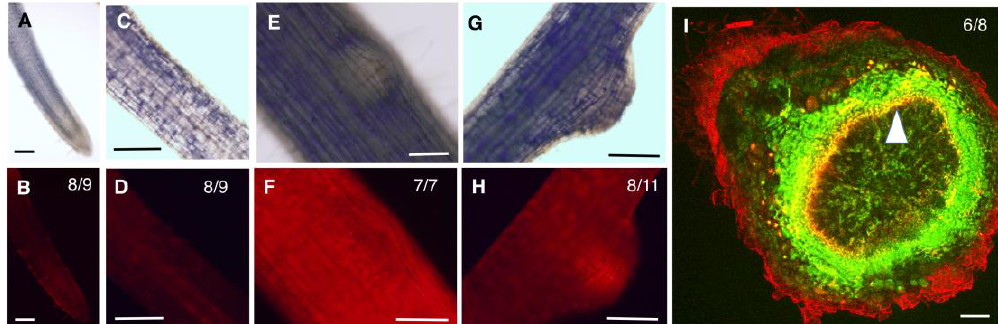
Figure 5. Spatio temporal expression patterns of GmZPR3d. Expression of GmZPR3dp:tdTomato in whole mounts of a soybean root tip ( A , B ), mature root region showing the root stele ( C , D ), an emerging lateral root ( E , F ), and an emerging nodule ( G , H ), imaged using a compound fluorescence microscope. A , C , E and G are bright field images and B , D , F and H are corresponding fluorescence images obtained using a PI/TRITC filter. ( I ) A median section of a mature nodule longitudinal to the nodule axis showing expression of GmZPR3dp:tdTomato in the nodule parenchyma imaged using a laser confocal microscope. Tdtomato (red) signal appears yellow due to overlap with a co-expressed constitutive GFP construct. Bright red fluorescence in the nodule and root peripheries and the root stele indicate non-specific fluorescence. See Figure S4 for split channels and color blind-friendly composite image. Scale bars are 100 µ m. The number of independent transgenic roots/nodules showing representative patterns out of the of the total number evaluated are indicated in panels B , D , F , H and I .